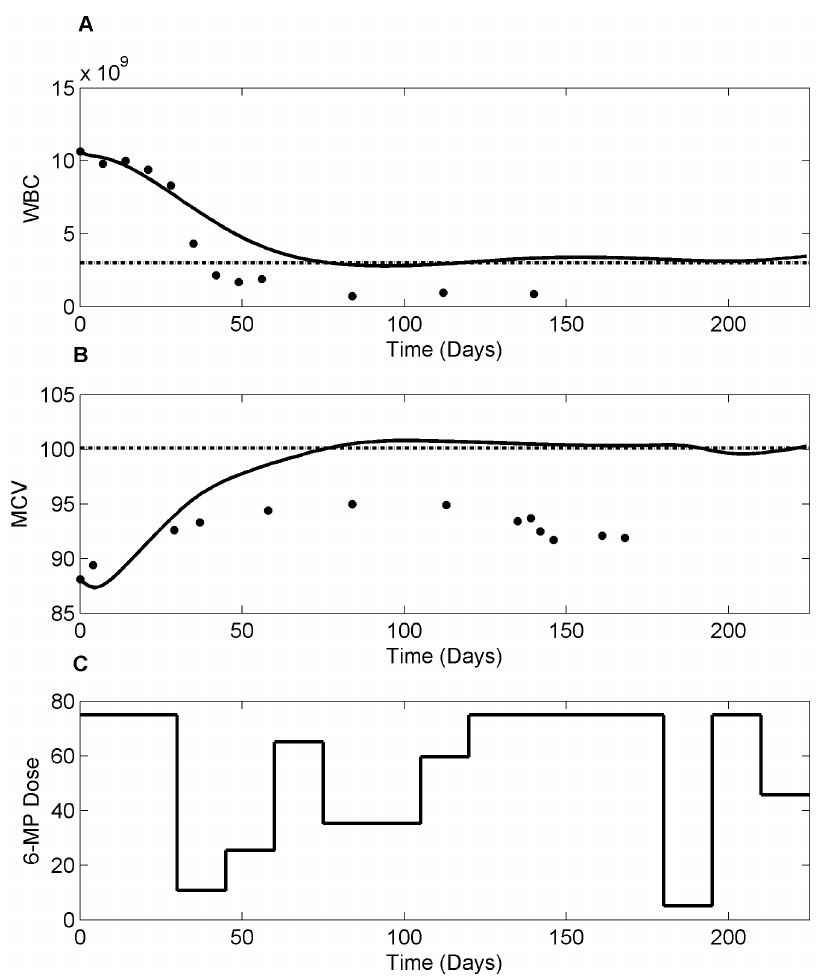
Figure 14. Optimal dosing based on leukocyte count and MCV as target. A. Evolution of leukocyte count in response to optimum 6-MP dosing. B. Evolution of D MCV response with optimum 6-MP dose. Dashed lines represent critical leukocyte and target MCV levels and solid dots represent clinical data for an average patient. C. Optimum 6-MP dosing profile predicted by NMPC. The standard daily 6-MP dosing is 75 mg/day.